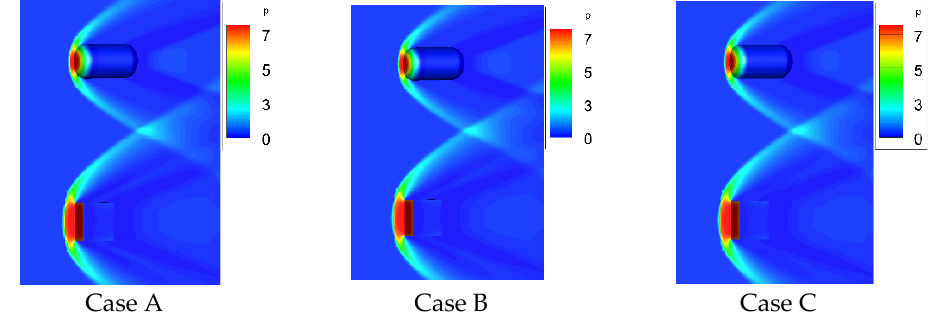
Figure 6. Dimensionless pressure contours of flows around the propulsion cylinders and low-temperature lock cabinets placed and paralleled with Δ y = 4.5D. Table 2. Axial and normal force coefficients when the propulsion cylinders and low-temperature lock cabinets are placed and paralleled with different grids.